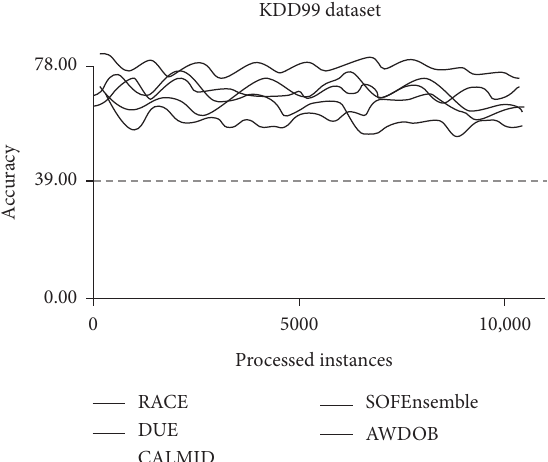
Figure 8: Prediction accuracy of the five algorithms on the KDD99